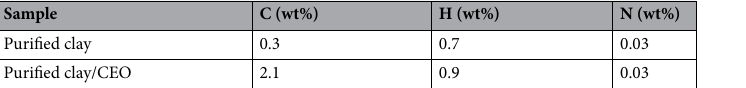
Table 6. Elemental analyses (CHN) of the starting materiel purified clay before and after adsorption of the CEO.